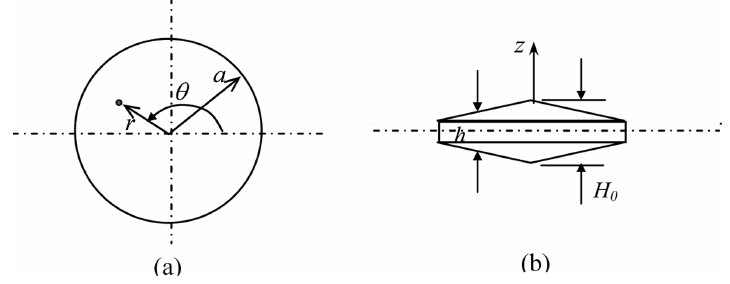
Fig. 1. Plate geometry: (a) plan view and (b) side